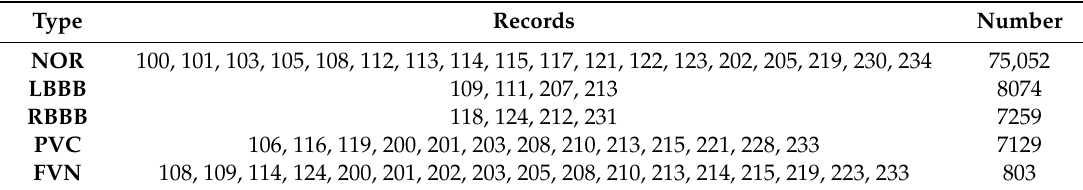
Table 4. Number of ECG beats per class in the MIT-BIH database.